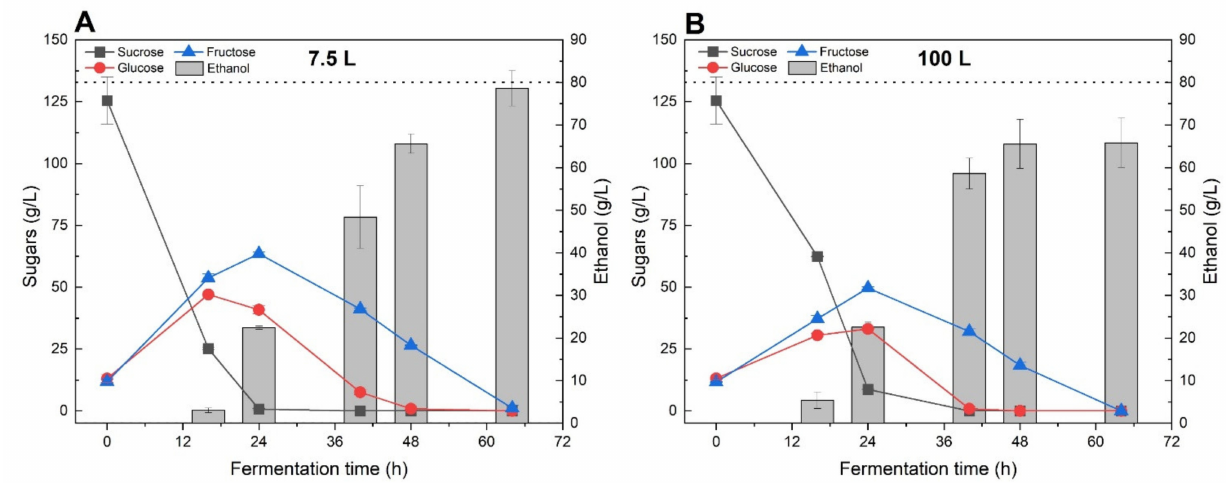
Figure 6. Ethanol and sugar concentration variations during fermentation scale-up assays performed in 7.5 L ( A ) and 100 L ( B ) batch bioreactors. Non-treated diluted sugar beet molasses with a total initial sugar concentration of 145 g/L was used for this experiment with 4.0 g/L of nutrient and 0.27 g/L of yeast. The dashed line refers to the theoretical maximum ethanol